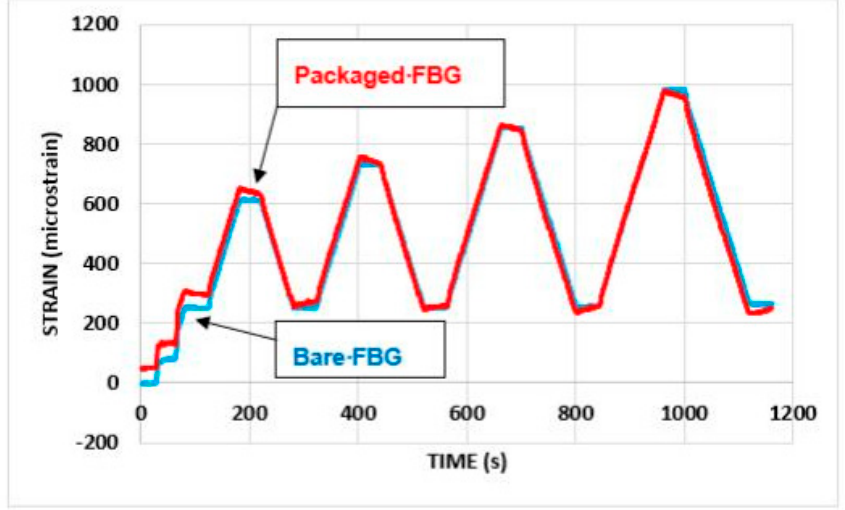
Figure 13. Open-top package: response to load cycles to 5.0, 6.0, 7.0 and 8.0 kN (total load).